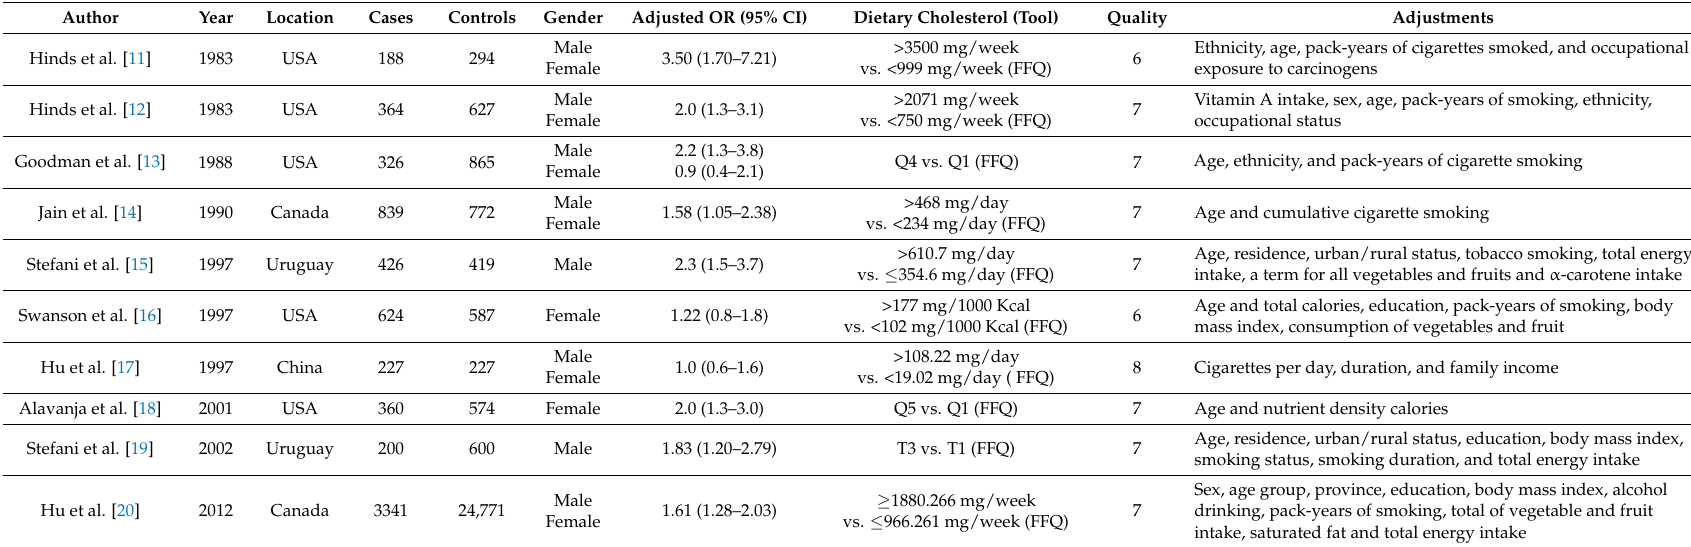
Table 1. Case-control studies included in the meta-analysis.